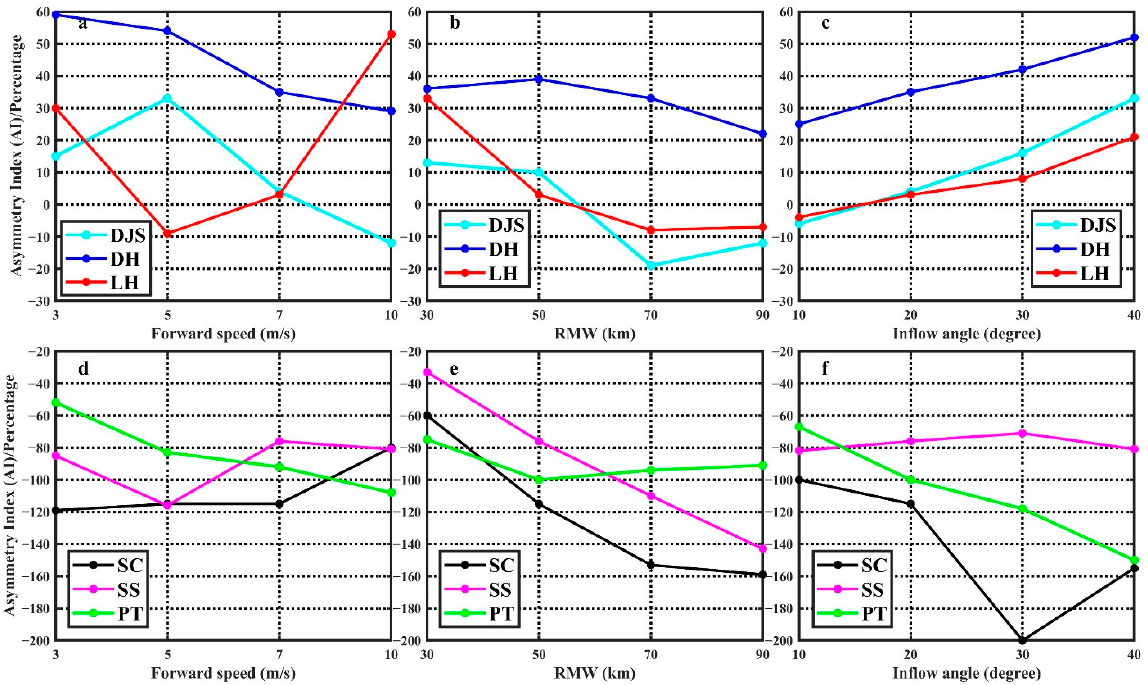
Figure 6. The relationship among asymmetry index (AI) and forward speed ( a , d ), RMW ( b , e ), and inflow angle ( c , f ) at six stations.